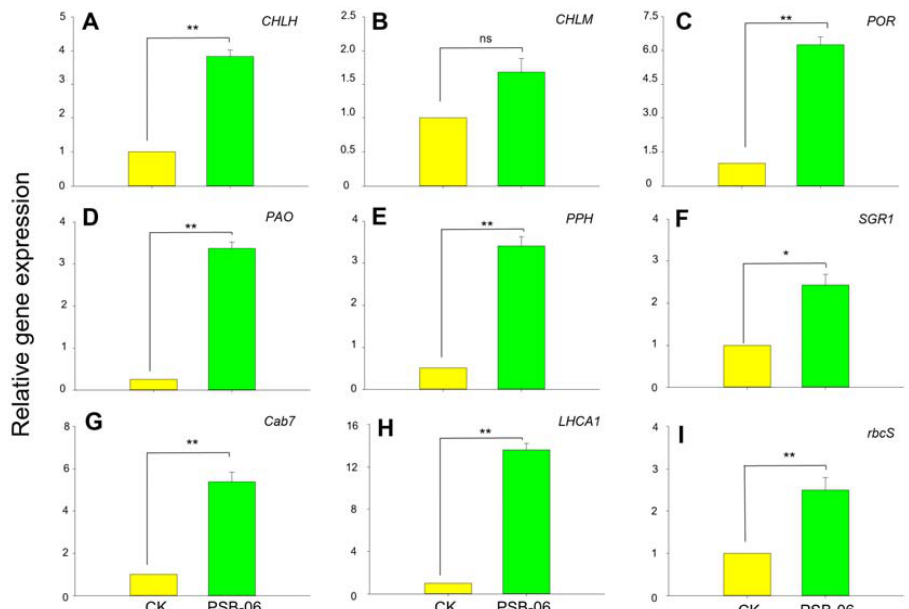
Figure 4. Treatments of PSB-06 affected the development of chlorophyll and the genes relating to Figure 4. Treatments of PSB ‐ 06 affected the development of chlorophyll and the genes relating to chlorophyll metabolism and photosynthesis in tomato plants after 45 days. The relative expression of chlorophyll metabolism and photosynthesis in tomato plants after 45 days. The relative expression of CHLH, CHLM and POR in the chlorophyll development pathway ( A – C ). The relative expression CHLH, CHLM and POR in the chlorophyll development pathway ( A – C ). The relative expression of of PAO, PPH and SGR1 in the chlorophyll metabolic pathway ( D – F ). The relative expression of PAO, PPH and SGR1 in the chlorophyll metabolic pathway ( D – F ). The relative expression of Cab7, Cab7, LHCA1 and rbcS in the photosynthetic pathway ( G – I ). CK: The tomato plants treated with LHCA1 and rbcS in the photosynthetic pathway ( G – I ). CK: The tomato plants treated with water. water. PSB ‐ 06: The tomato plants treated with PSB ‐ 06. Data are the mean ± SE, Different letters on PSB-06: The tomato plants treated with PSB-06. Data are the mean ± SE, Different letters on the bars the bars indicate significant differences. ** p < 0.01; * p < 0.05; ns, not significant. SE, standard error. indicate significant differences. ** p < 0.01; * p < 0.05; ns, not significant. SE, standard error. Figure 4. Treatments of PSB ‐ 06 affected the development of chlorophyll and the genes relating to chlorophyll metabolism and photosynthesis in tomato plants after 45 days. The relative expression of CHLH, CHLM and POR in the chlorophyll development pathway ( A – C ). The relative expression of PAO, PPH and SGR1 in the chlorophyll metabolic pathway ( D – F ). The relative expression of At 48 h AAP, the ToCV accumulation in the B. tabaci MED-fed ToCV-infected tomato Cab7, LHCA1 and rbcS in the photosynthetic pathway ( G – I ). CK: The tomato plants treated with plants that had been treated with PSB-06 was 1.66 × 10 6 copies/ µ L, and ToCV accumulation water. PSB ‐ 06: The tomato plants treated with PSB ‐ 06. Data are the mean ± SE, Different letters on in the B. tabaci MED-fed ToCV-infected tomato plants that had been treated with water was the bars indicate significant differences. ** p < 0.01; * p < 0.05; ns, not significant. SE, standard error. 1.20 × 10 6 copies/ µ L, i.e., 30% lower than the former (Figure 5A; F 1,6 = 4.270, p < 0.01).